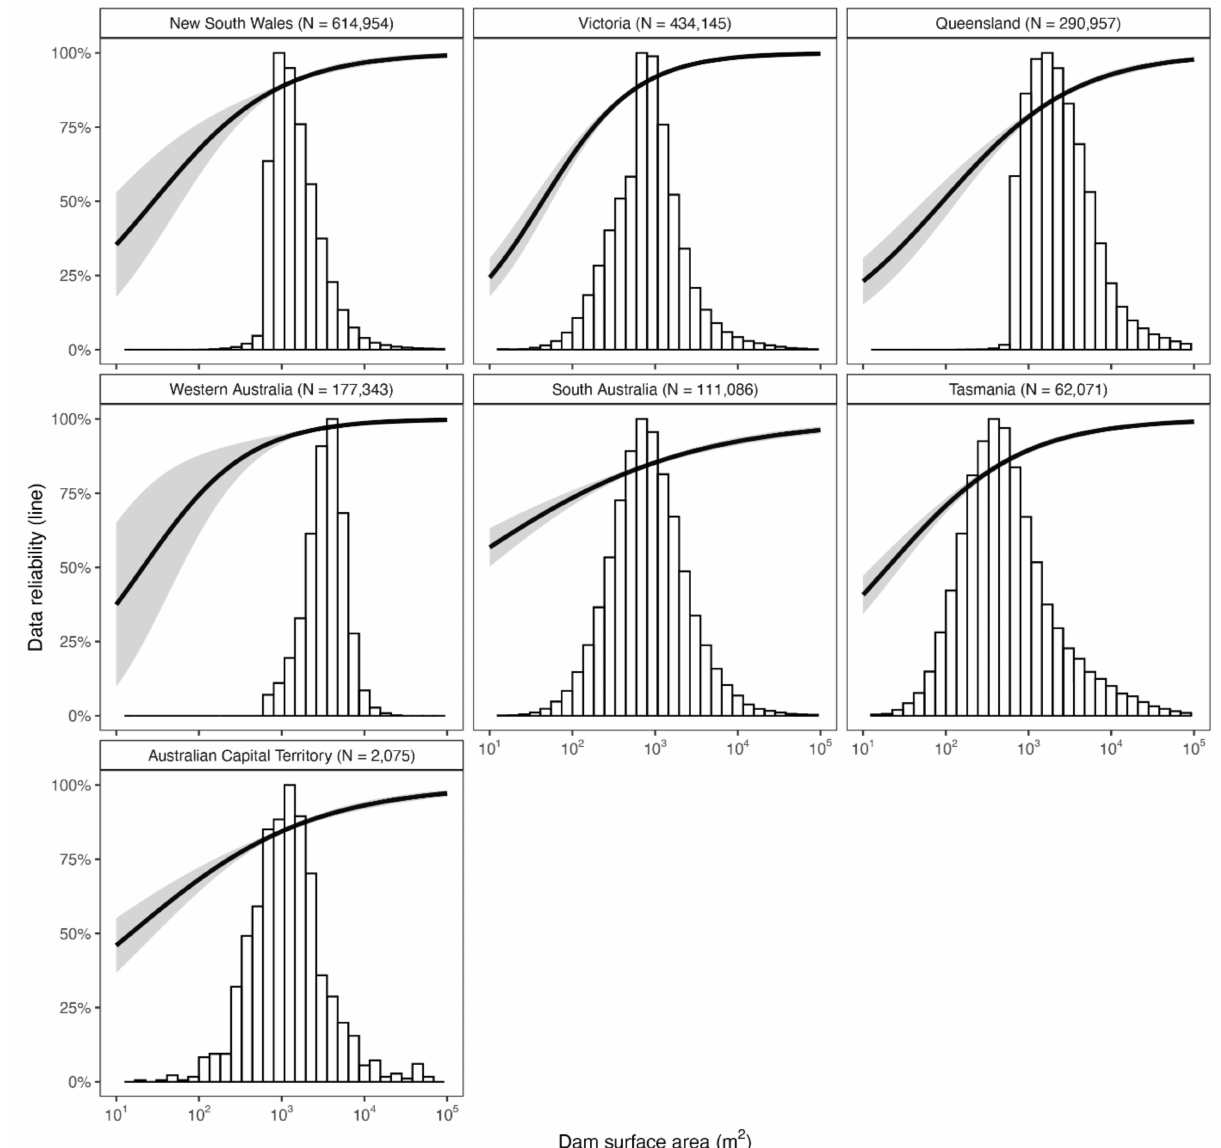
Figure 3. Dam detection reliability as a function of geographic region and dam surface area (m 2 ). Histograms and x- axes represent the distribution of all documented dam sizes, while faceting represent States and Territories in Australia (with sample size reported in the facet titles). Lines ( ± 95% C.I) indicate the probability of a reliable entry extracted from the best-fitting generalised linear model following Akaike Information Criterion. Low probabilities indicate high frequencies of wrongly classified dams (false positives), whereas high probabilities indicate high frequencies of dams correctly documented (true positives). We omitted data for the Northern Territories because there were too few documented dams to carry out a formal probability